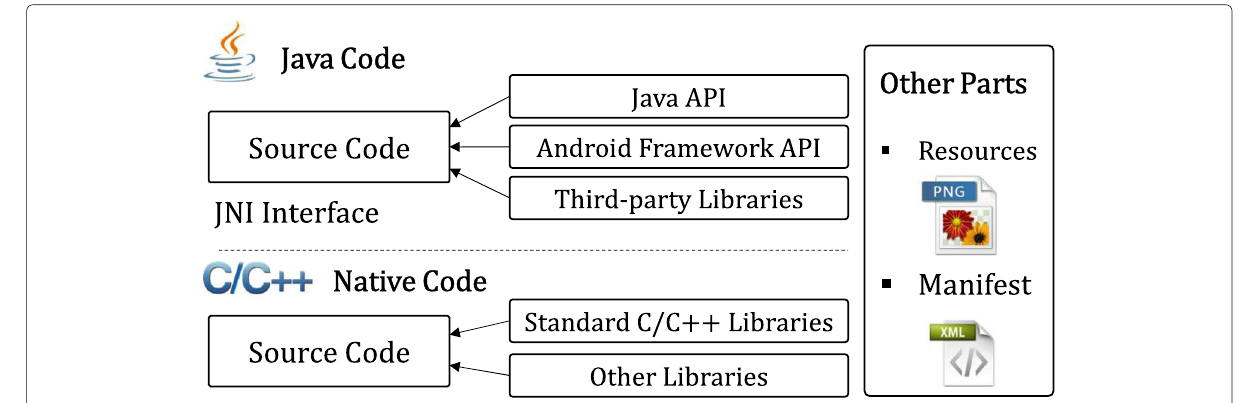
Fig. 1 General components of Android